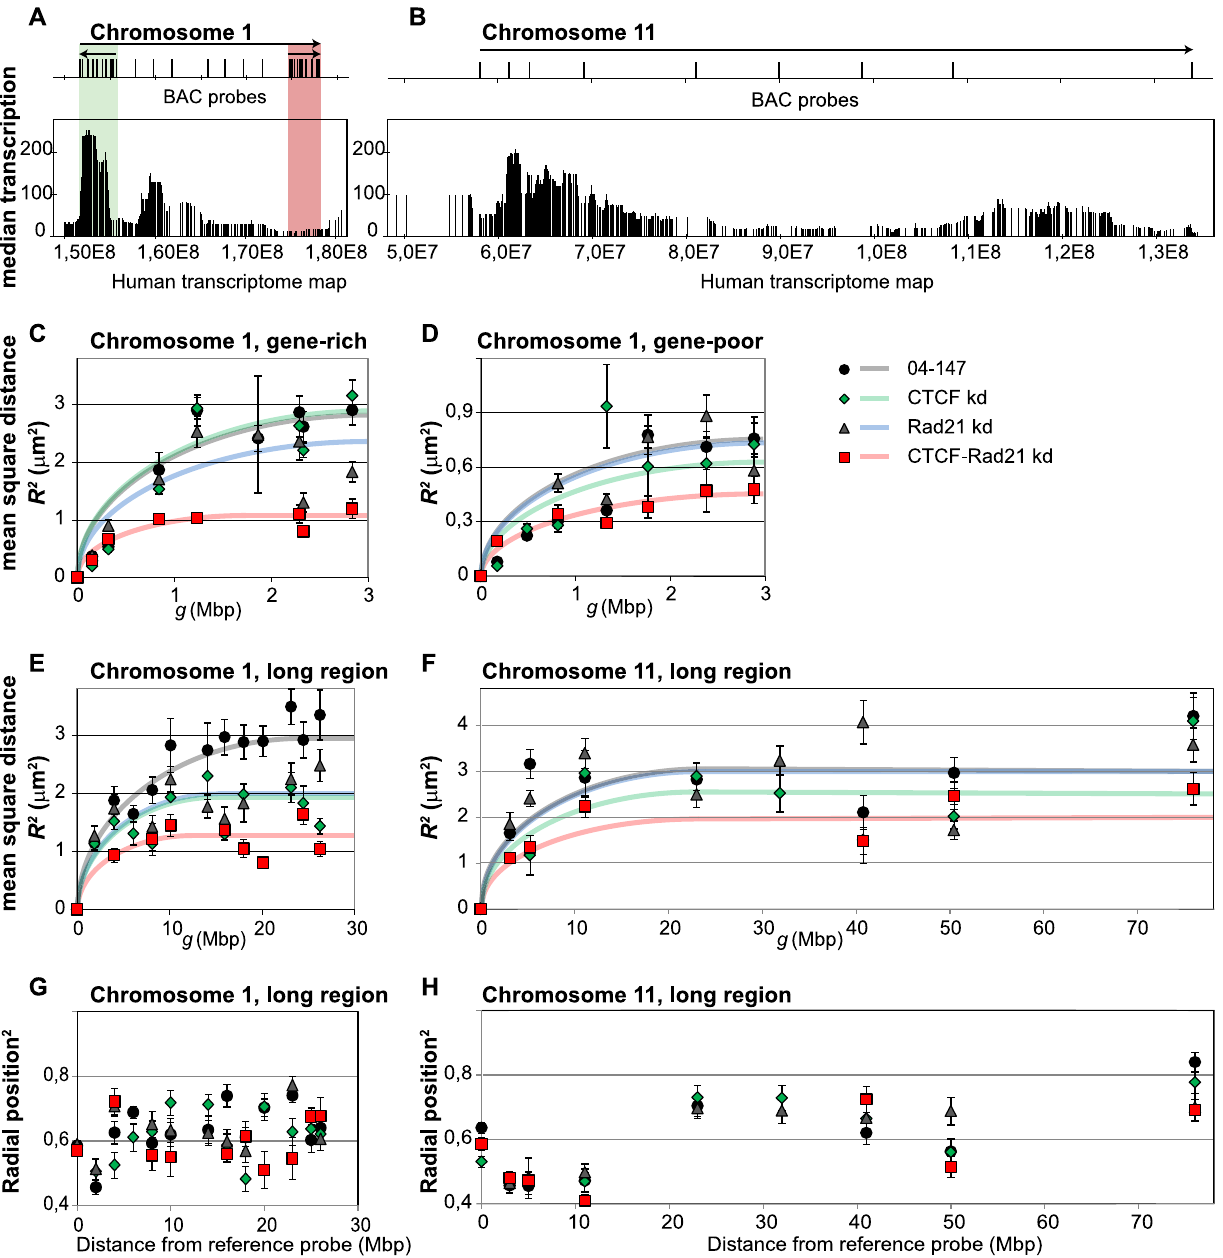
Figure 2. Insitu chromatin structure. ( A, B ) The genomic context of analysed regions of the q-arms of human chromosome 1 ( A ) and chromosome 11 ( B ) is illustrated by the human transcriptome map. Vertical lines represent protein coding genes, the length depicting the average transcription level in a number of human tissues and cell lines [42]. The location of BAC probes used for FISH labelling are indicated above the maps. Arrows above the maps designate the regions where spatial distances between pairs of BAC probes were measured; the start of the arrow indicating the position of the reference BAC probe. On chromosome 1q three regions were analysed. Two 3 Mb regions were selected in a gene-rich and transcriptionally active region (green box) and in a region characterized by low gene density and low transcription (red box). ( C–F ) Graphs show the mean square physical distances , R 2 . between the FISH probes as a function of the genomic distance g for a 3 Mb gene-rich ( C ) and a gene-poor ( D ) region on chromosome 1 q-arm. Longer regions of chromosome 1 (30 Mb) ( E ) and of chromosome 11 (76 Mb) ( F ) were also analysed. Each data point represents an average of 30–150 distance measurements in at least two independent experiments. Error bars represent standard errors. Graphs are shown for control cells (black dots) and cells after knockdown of CTCF (green diamonds), of cohesin subunit Rad21(blue triangles) and of CTCF and Rad21 simultaneously (red squares). Results show that chromatin becomes more compact after knockdown of CTCF and Rad21 (cohesin). ( G, H ) Radial positions of BAC probes in nuclei for chromosome 1q (G) and chromosome 11q (H). Radial nuclear position of a BAC probe was calculated the distance between the centre of gravity of a FISH labelled genomic site and the centre of gravity of the nucleus and dividing that distance with the length of a straight line drawn from the nuclear centre to the nuclear envelope through the centre of the gravity of the labelled site. Error bars represent standard errors. Note that some chromatin regions were poorly labelled in CTCF and/or cohesin knock down conditions and therefore omitted from the graph.